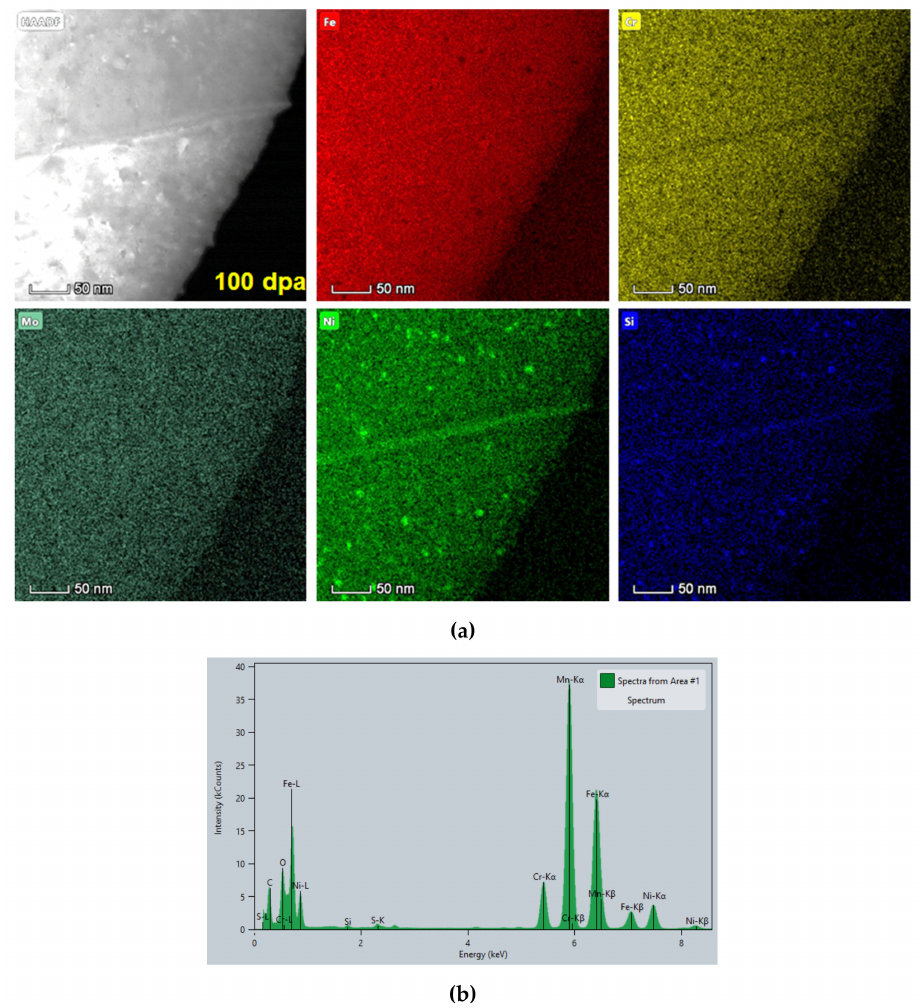
Figure 20. ( a ) Spectral image of a slightly off-vertical grain boundary and adjacent matrix in the 100 dpa FTT material, clockwise from upper left: HAADF image and element maps for Fe, Cr, Si, Ni and Mo. ( b ) the X-ray energy spectrum extracted from the spectrum image area, showing the very strong Mn-K α and K β peak caused by the radioactivity of the specimen. The strong Mn peaks made semi-quantitative analysis of Fe and Cr too